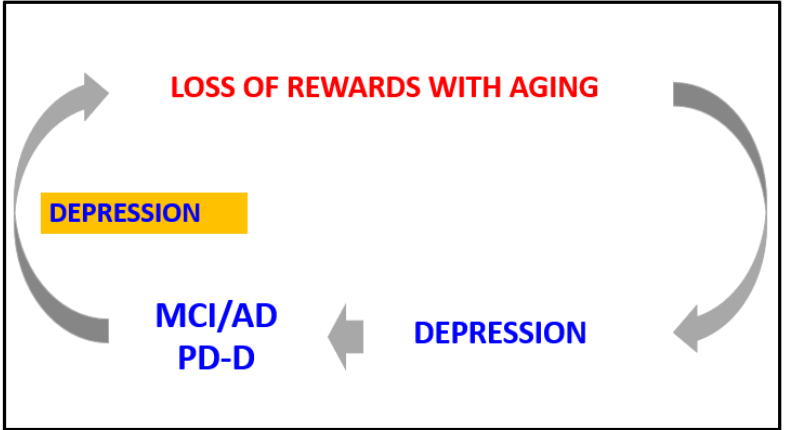
Figure 2. Hypothetical loop explaining the potential link between age-related changes in rewards system, depression, Mild Cognitive Impairment (MCI), Alzheimer’s Disease (AD) and Parkinson’s Disease (PD) Dementia.